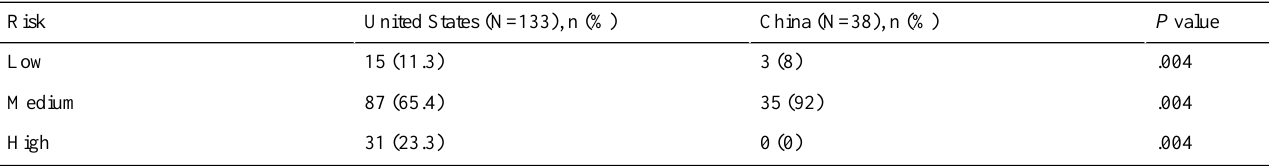
Table 2. The risk assessment of mobile apps for diabetes self-management between the United States and